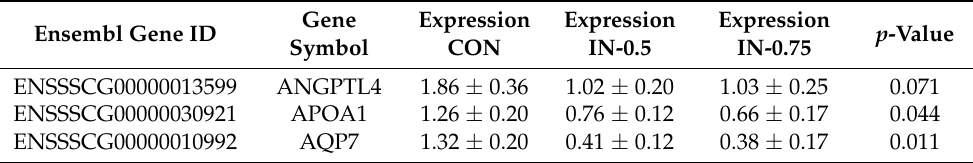
Table 3. Validation of differentially expressed genes in the comparisons between the CON group and the IN-0.5 group or the CON group and the IN-0.75 group by qPCR. Numbers are relative expression values in relation to the geometrical mean of the expression of ACTB and GAPDH. One-way ANOVA was used to obtain the p -value. n = 7 for CON, n = 8 for IN-0.5, and n = 8 for